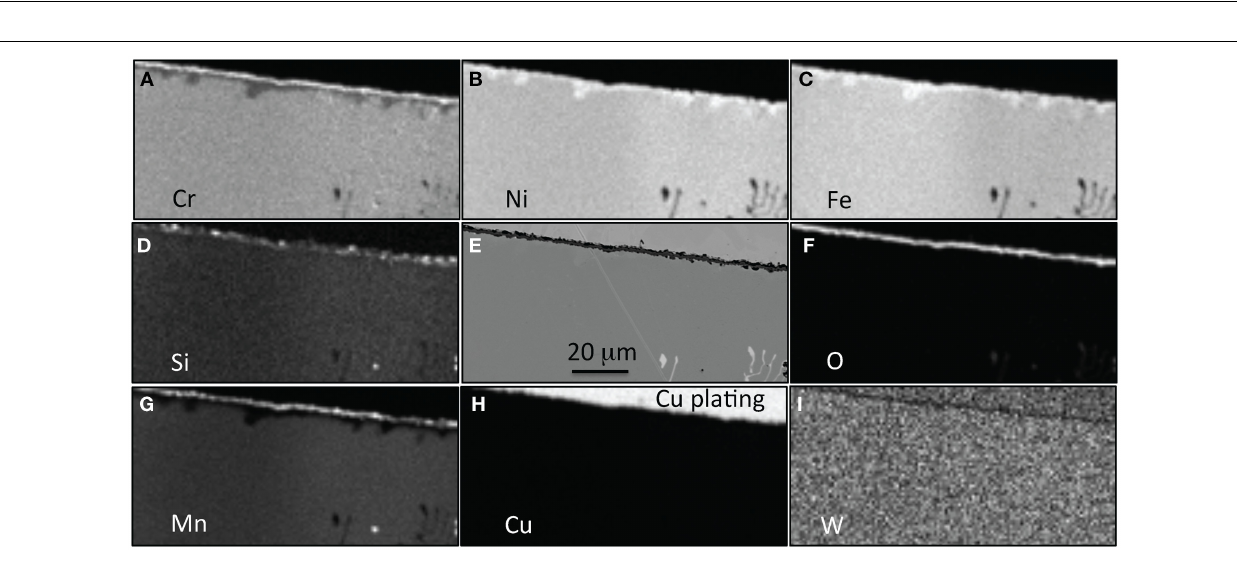
FIGURE 5 | EPMA mapping for alloy 22Cr–17.5Ni after exposure for 1000h in air +++ 10% H 2 O at 700°C, (A) Cr, (B) Ni, (C) Fe, (D) Si, (E) SEM picture, (F) O, (G) Mn, (H) Cu, and (I) W